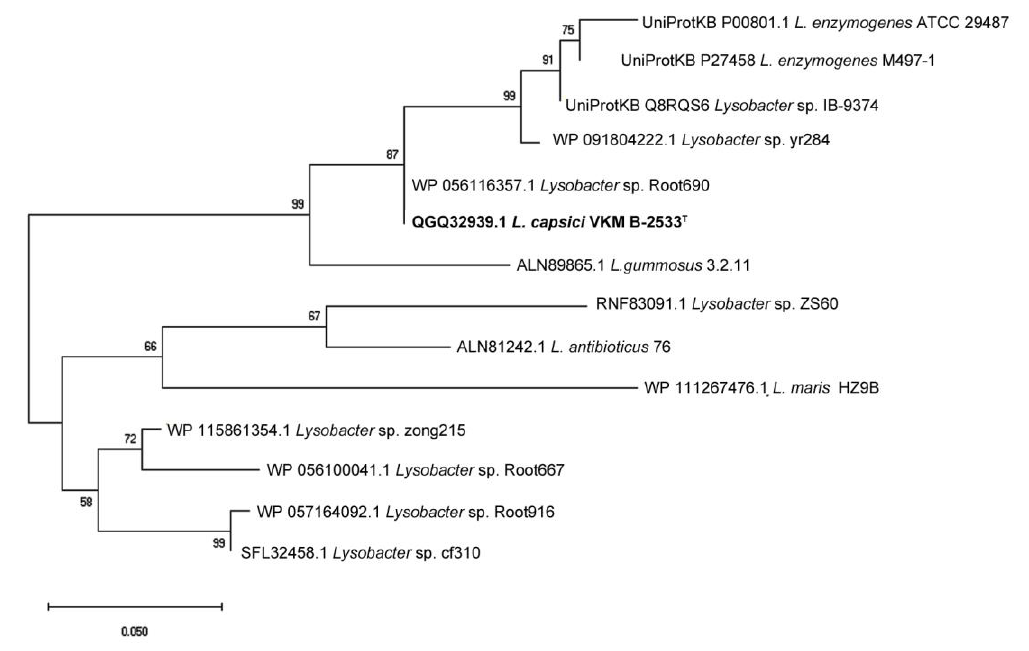
Figure 2. Dendrogram of Blps of Lysobacter bacteria.